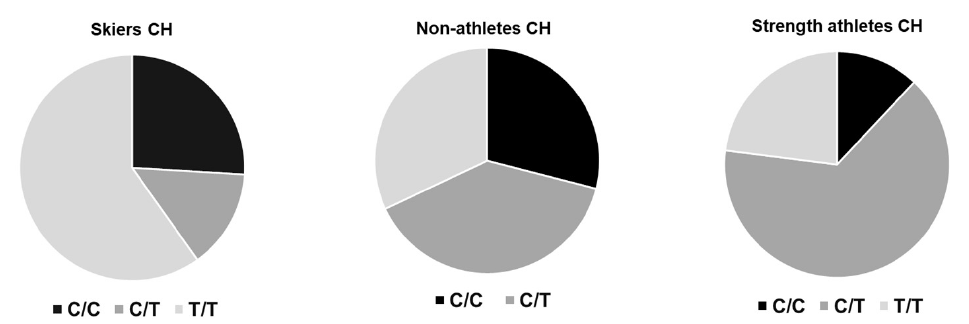
Figure 1. Genotype distribution across alpine and cross-country skiing. Pie charts depicting the frequency of the three genotypes of the ACTN3 gene polymorphism rs1815739 for the studied elite skiers and controls from previous studies with strength athletes and nonathletes from the same country [27,28].